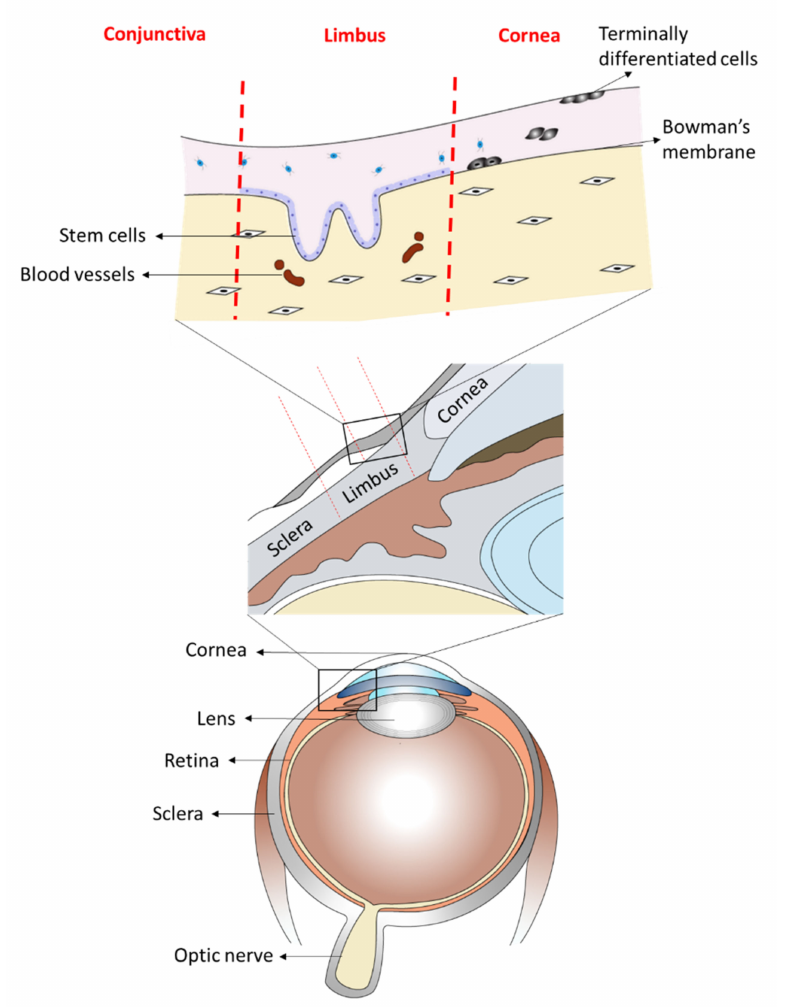
Figure 1. A scientific illustration of human ocular anatomy showing the anterior part of the eye with two phenotypically and functionally distinct structures. The transparent front layer of the eye, the cornea, which is covered by the corneal epithelium and the anterior sclera, that encircles the cornea and covered by the conjunctival epithelium that also extends to cover the inner surface of the eyelids. Both these cell types are separated by the limbus, which is the reservoir of the stem cells for the corneal